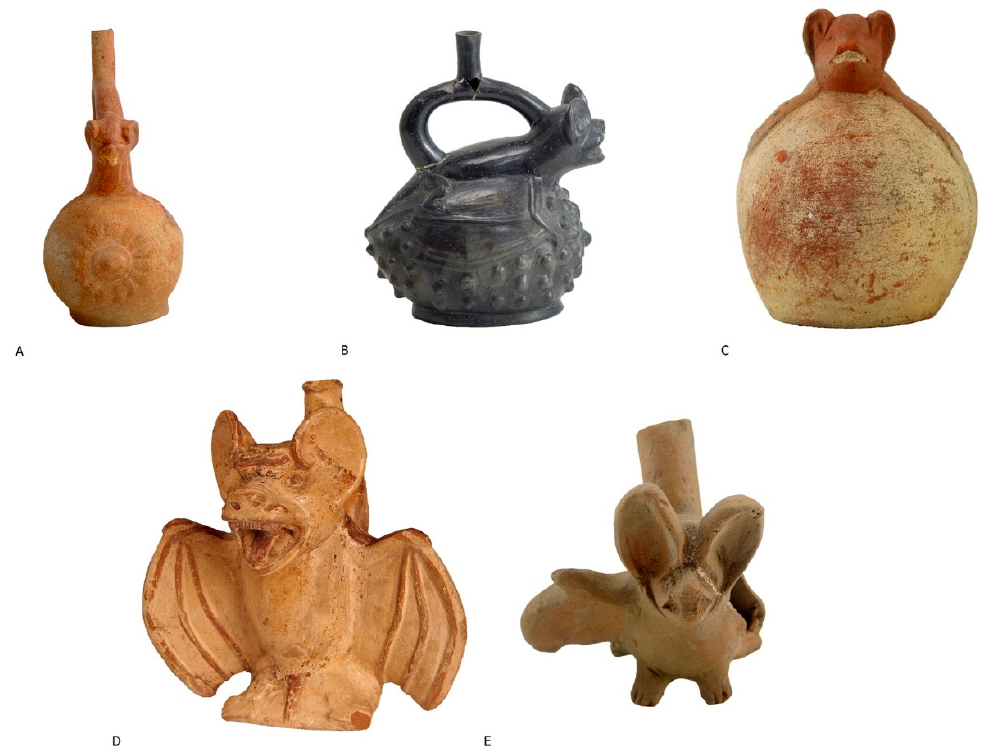
Figure 5. Naturalistic depictions of bats in stirrup jars: ( A ) bat on fruit with smooth skin, Molossidae (ML007237); ( B ) bat on fruit with protrusions on skin, Molossidae (ML007349); ( C ) bat on globular base, Molossidae (ML009873); ( D ) bat with flared wings, Phyllostomidae (ML008255); ( E ) bat with flared wings, Phyllostomidae, possibly genus Lophostoma or Micronycteris (ML014246) (Museo Larco, Lima—Perú).